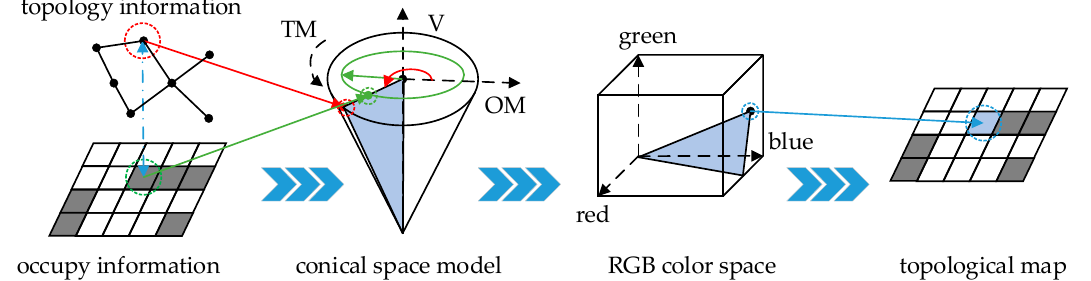
Figure 3. Topological map preservation process.